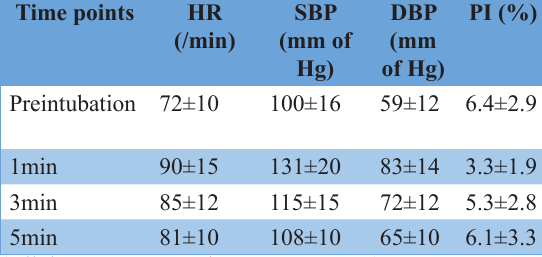
Table 2. Time trend of hemodynamic changes.